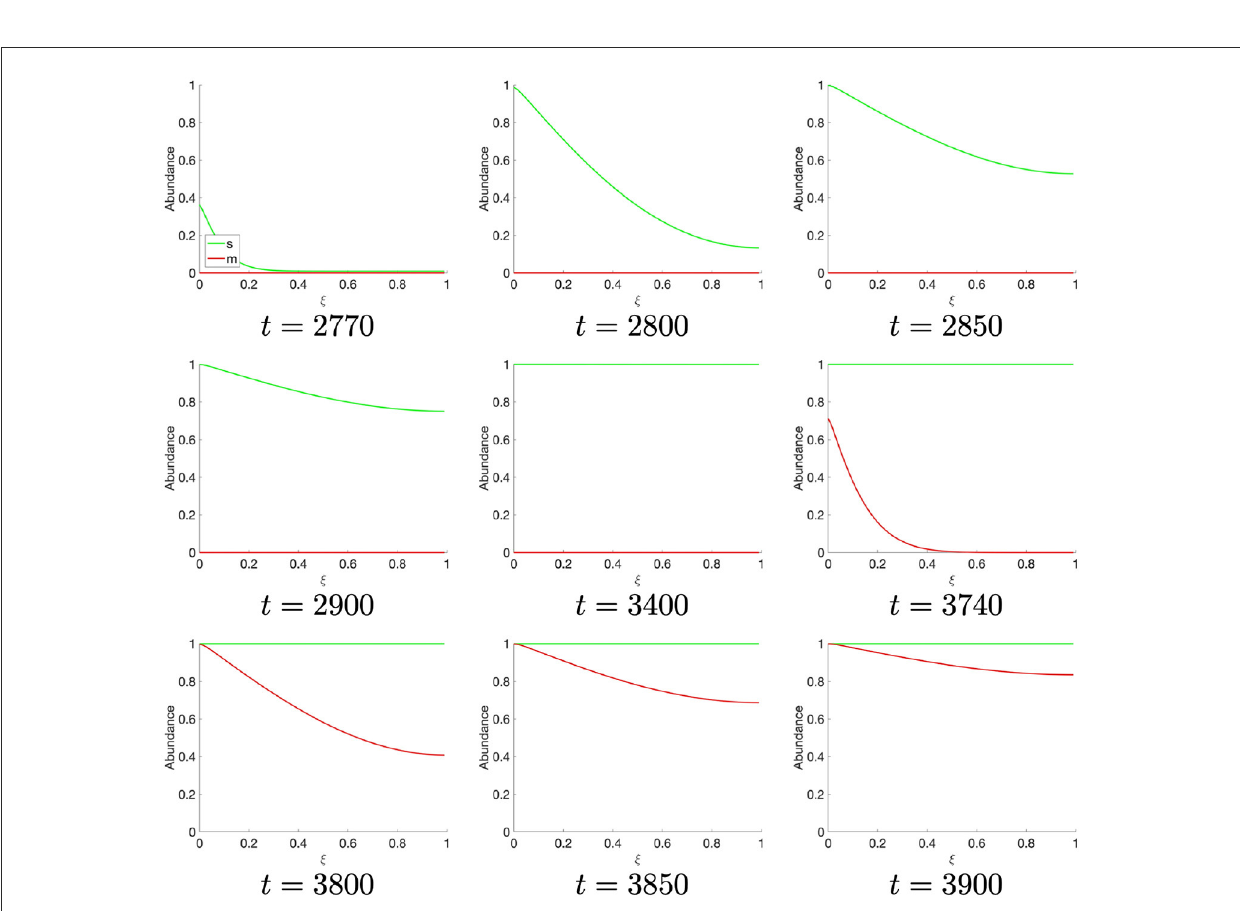
FIGURE4 Spatial S- and M-cyclin state estimated for t